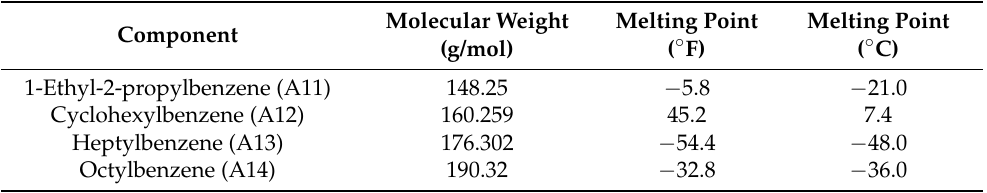
Table 3. Molecular weights and melting points of heavy aromatic hydrocarbons